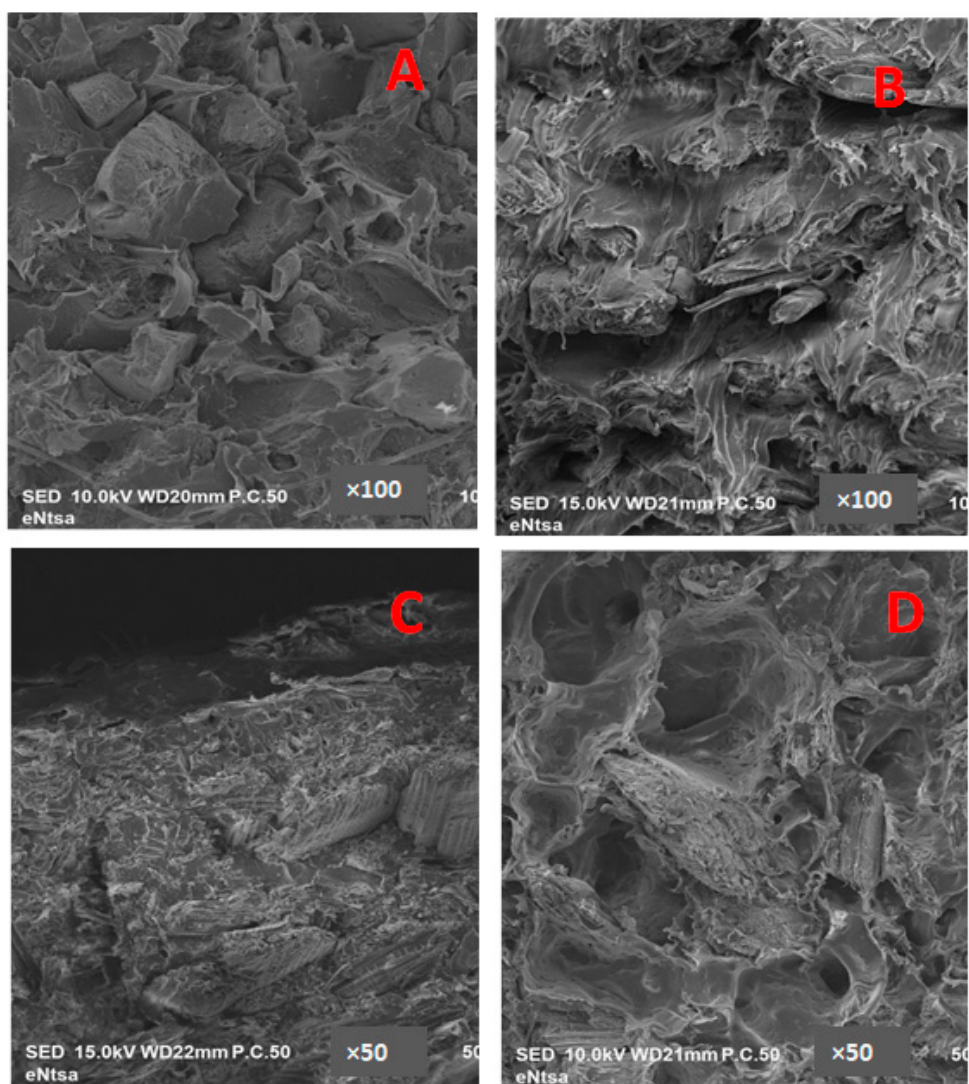
Figure 9. Scanning electron microscopy images of PP/GTR/WF composites with a magnification of 200 µ m ( A ) Sample 1 with compatibilizer ( B ) Sample 2 with compatibilizer, ( C ) Sample 4 without compatibilizer, and ( D ) Sample 4 with compatibilizer.